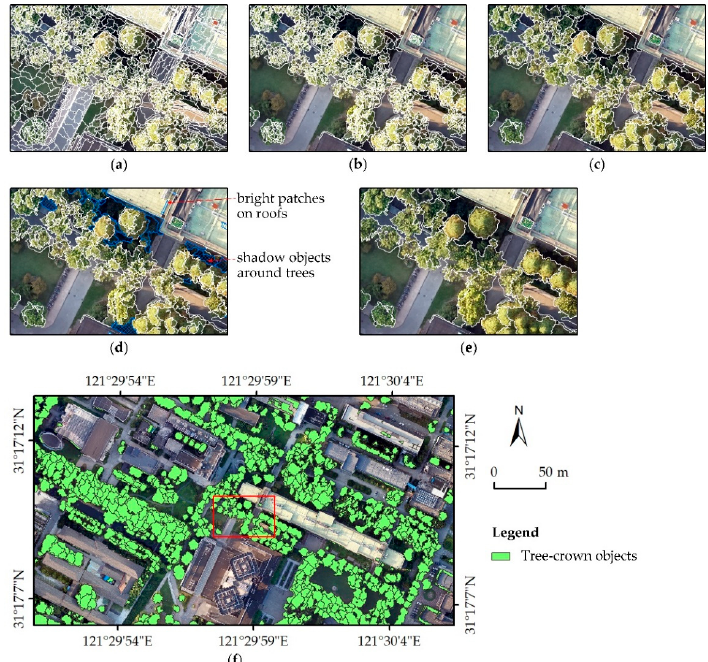
Figure 4. Portions of tree-crown object extraction results at each step ( a – e ) and final result of study area ( f ): The initial image objects with white boundaries ( a ); The potential tree-crown objects shown in white are extracted and the others are masked out ( b ); The merging objects with white boundaries ( c ); The misidentified objects shown in blue are eliminated ( d ); The merging objects with white boundaries ( e ). The extracted tree-crown objects in the study area colored in green ( f